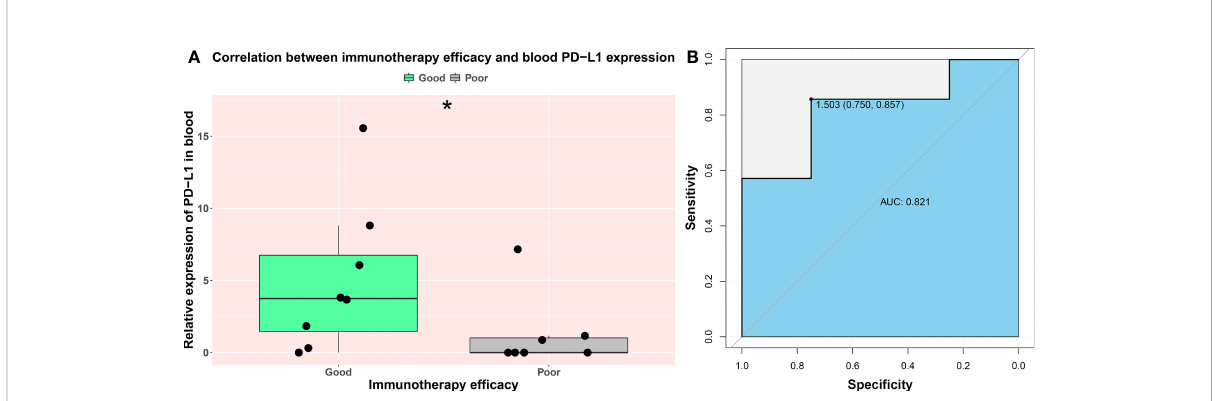
FIGURE 5 The prognostic value of PD-L1 expression in blood on immune ef fi cacy. Each patient was grouped into a good (CR and PR) and poor (SD and PD) cohort based on their immunotherapy outcomes. (A) The comparison of blood PD-L1 expression level between good and poor cohort. (B) The ROC curve of blood PD-L1expression and immunotherapy ef fi cacy. AUC indicates area under the ROC curve; “ * ” indicates p-value <